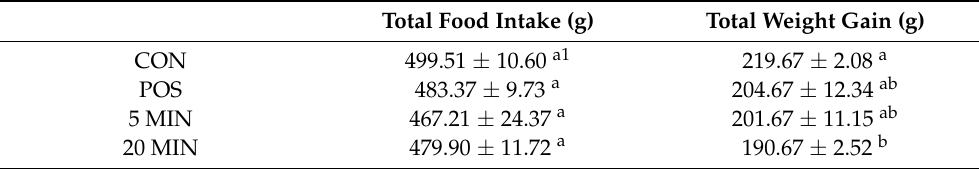
Table 2. Total food intake and total weight gain during the animal experiment. CON: chronic stress- exposed control group; POS: linalool (positive control) inhalation by chronic stress-exposed rats; 5 MIN: BEO inhalation for 5 min by chronic stress-exposed rats; 20 MIN: BEO inhalation for 20 min by chronic stress-exposed rats.